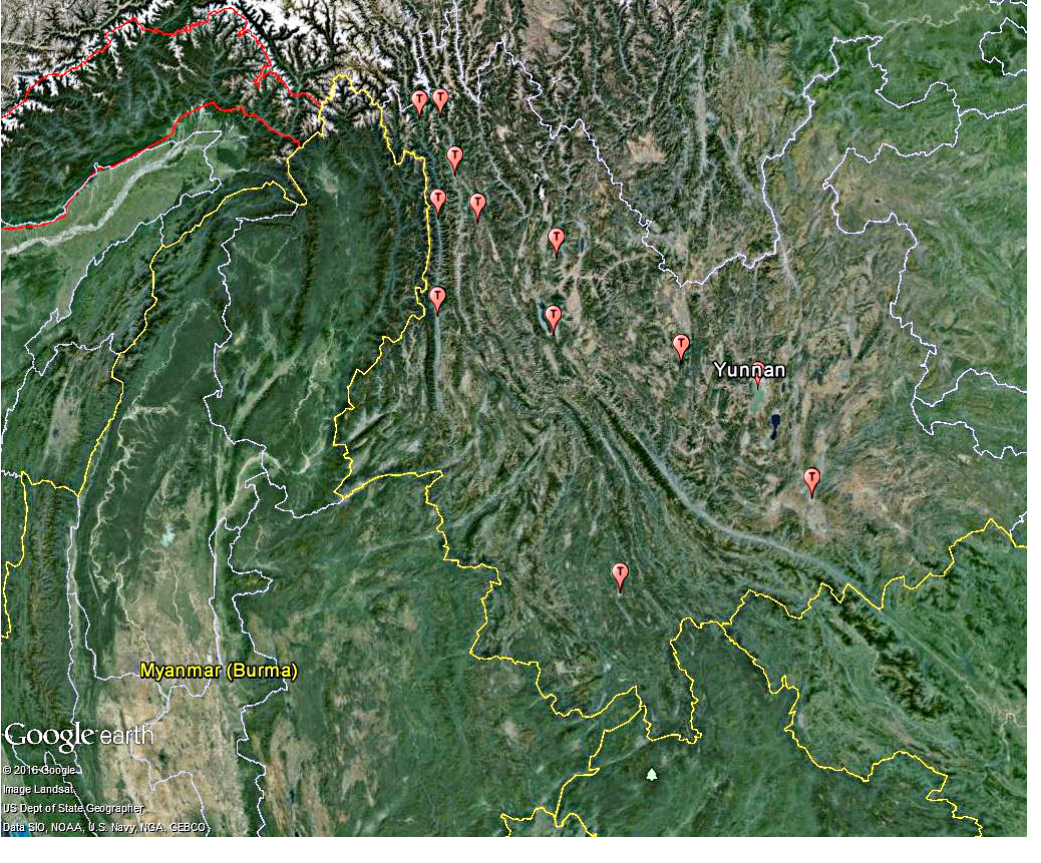
Fig. 10. Localities in Yunnan where specimens of Hybovalgus thibetanus (Nonfried, 1891) were collected. Base Map from Google